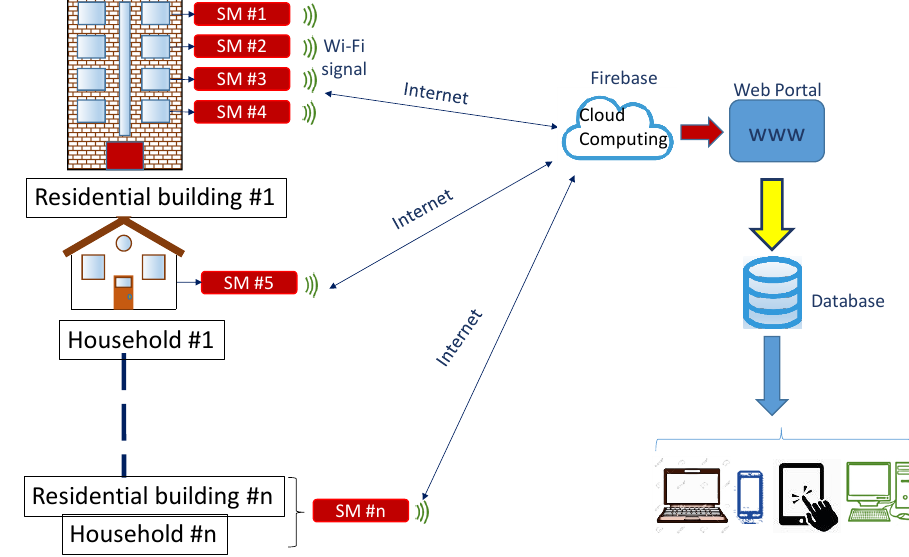
Figure 2. Remote real-time data collection schematic.